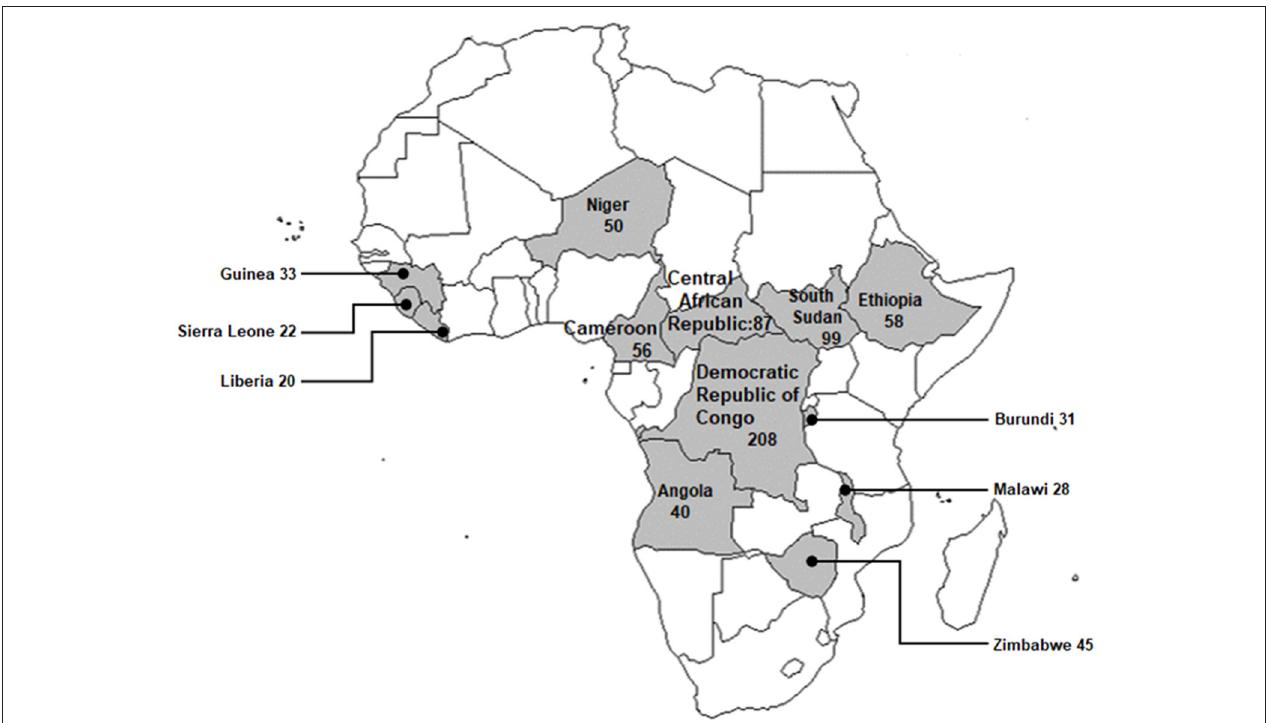
FIGURE 2 | Distribution of total PHE counts by country from 2010 to